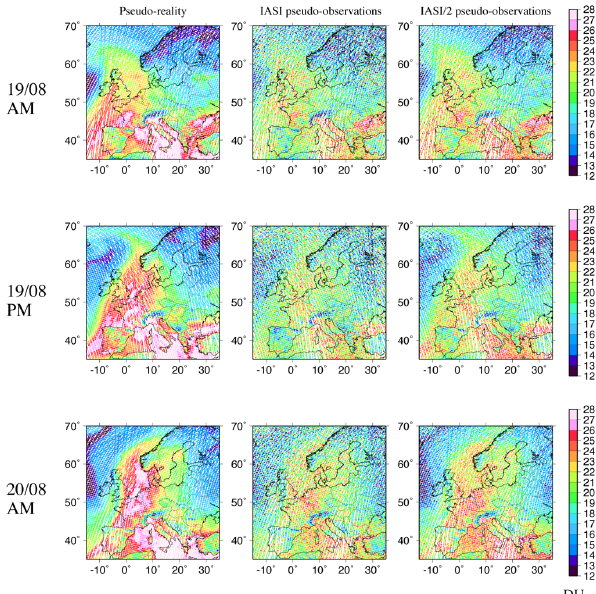
Fig. 8. Surface–6km TOC for 19 August 2009 AM–20 Au- gust 2009 AM, MOCAGE pseudo-reality (column 1), IASI and IASI/2 pseudo-observations (columns 2 and 3).